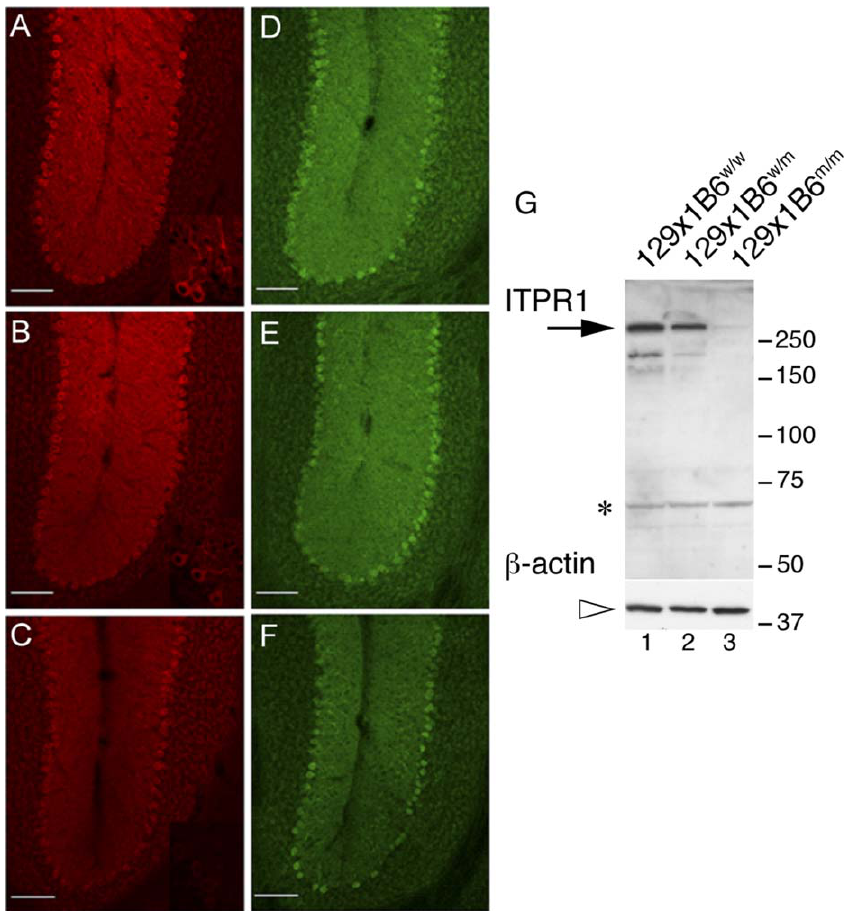
Figure 1. Immunohistochemistry and Western Blot Analysis of ITPR1 Protein Levels in Mouse Cerebellum (A–F) Immunohistochemistry of cerebellum from a wild-type mouse (A and D), a mouse heterozygous for the Itpr1 18-bp deletion (B and E), and a mouse homozygous for the 18-bp Itpr1 deletion (C and F). (A–C) Immunohistochemistry using polyclonal Itpr1 anti-rabbit antibody (1:2,000; Alexa Fluor 555); (D–F) immunohistochemistry using monoclonal Calb1 anti-mouse antibody (1:6,000; Alexa Fluor 488). Scale bars denote 100 l m. As previously described, Iptr1 is highly expressed in the Purkinje cells. Notably, there appears to be decreased immunoreactivity to Itpr1 in the heterozygous and homozygous mutant mice. (G) Western blot performed to examine Itpr1 levels in whole brain from wild-type, Itpr1 wt/ D 18 , and Itpr1 D 18/ D 18 mice; this clearly shows a reduction of Itpr1 in brain tissue from Itpr1 wt/ D 18 mice and a greater reduction of Itpr1 in Itpr1 D 18/ D 18 mice.